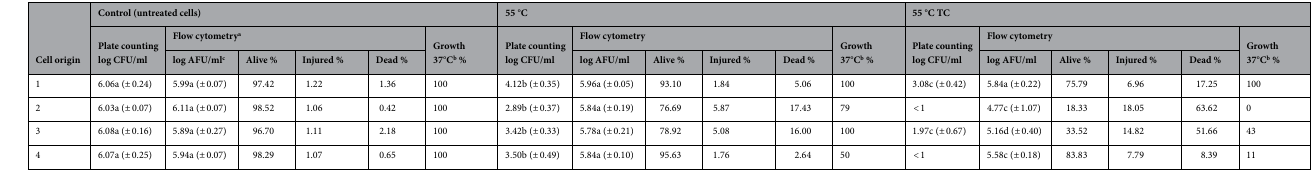
Table 1. Viability, culturability, and recovery in BHI broth of L. monocytogenes cells after mild heat treatment combined with terpens. a Data are reported as total cells counted clustered as AFU (considered as alive cells), injured and non-AFU (considered as dead cells), expressed as percentages of the total cell number. For each inoculum, significant differences in culturability and viability between samples according to ANOVA are indicated by lowercase letters. b Expressed as percentage of growth after the different treatments in the 28 repetitions for each